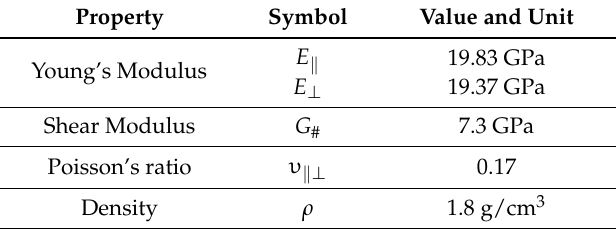
Table A1. Mechanical material parameters of the TEPEX ® 102-RG600(x)/47% tested according to DIN EN ISO 527-4 and DIN EN ISO 14129 standards or provided by the manufacturer in [29].